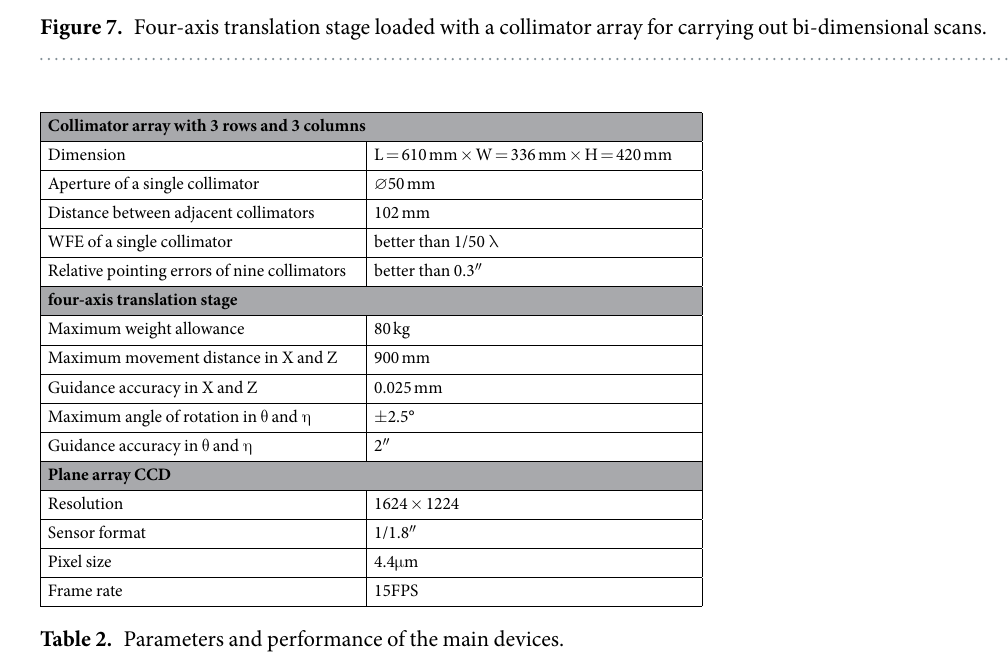
Table 2. Parameters and performance of the main